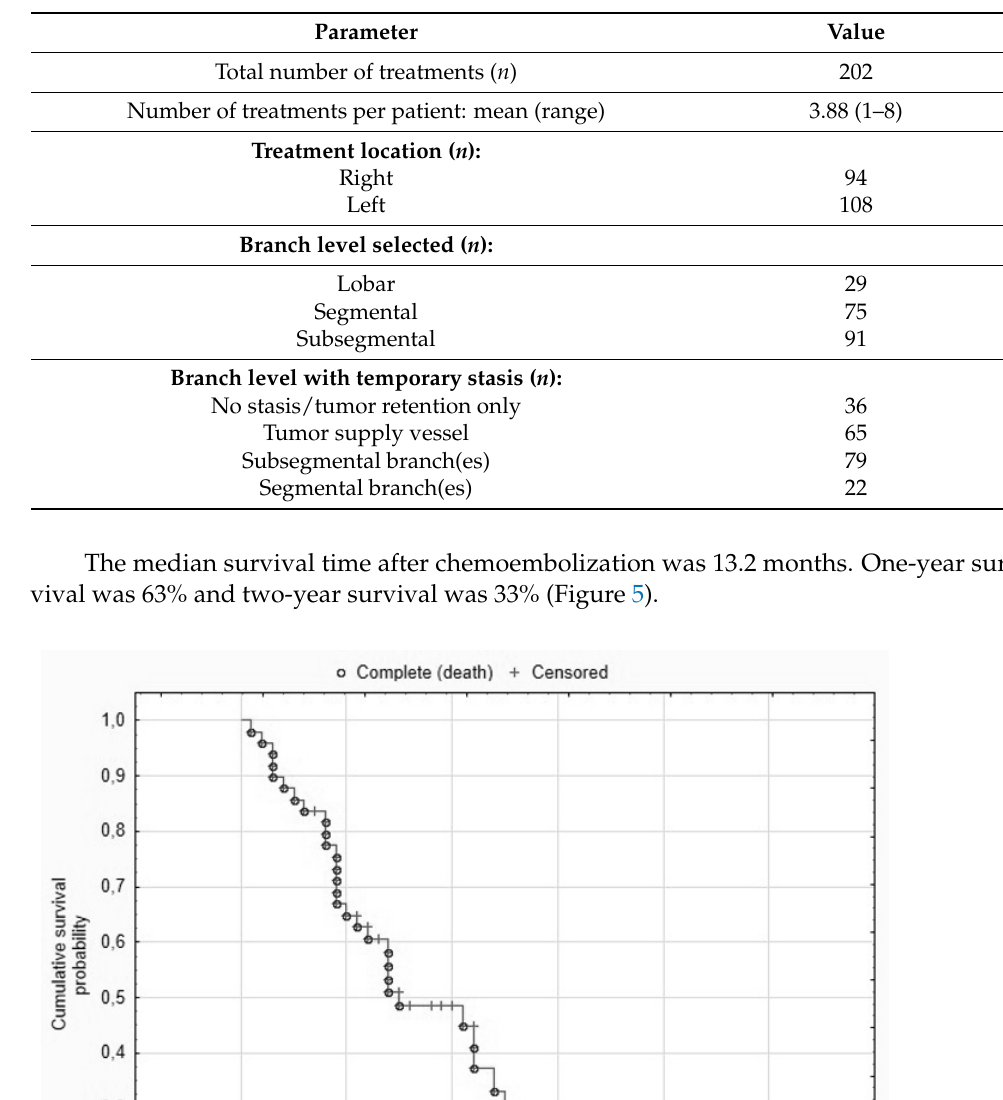
Table 4. Branch level of temporary stasis associated with mean severity of postembolization syn- drome (PES). Branch Level of Stasis